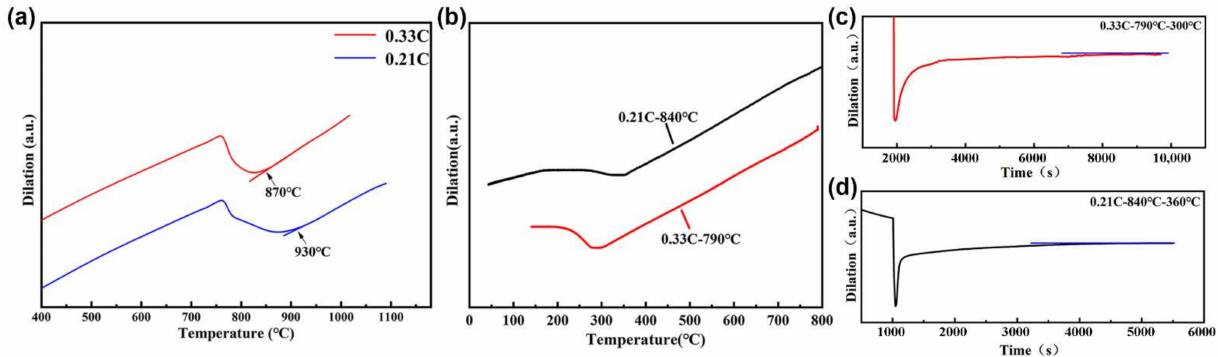
Figure 2. ( a ) Dilation–temperature curves to measure the Ac 3 temperature, ( b ) dilation–temperature curves to measure the Ms temperature after intercritical annealing, ( c ) dilation–time curves of the 0.33C steel, and ( d ) 0.21C steel holding at the Ms